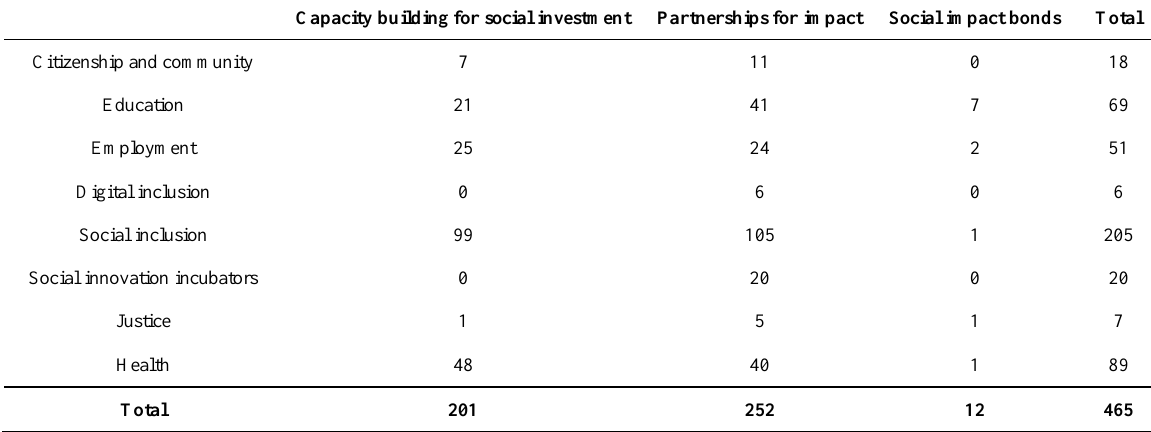
Table 3. Distribution of projects by type of